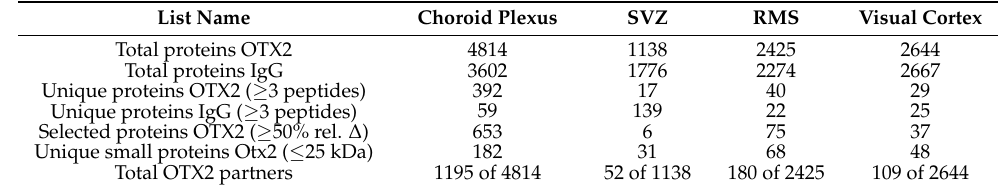
Table 5. Summary of protein lists and criteria for identification of putative OTX2 protein